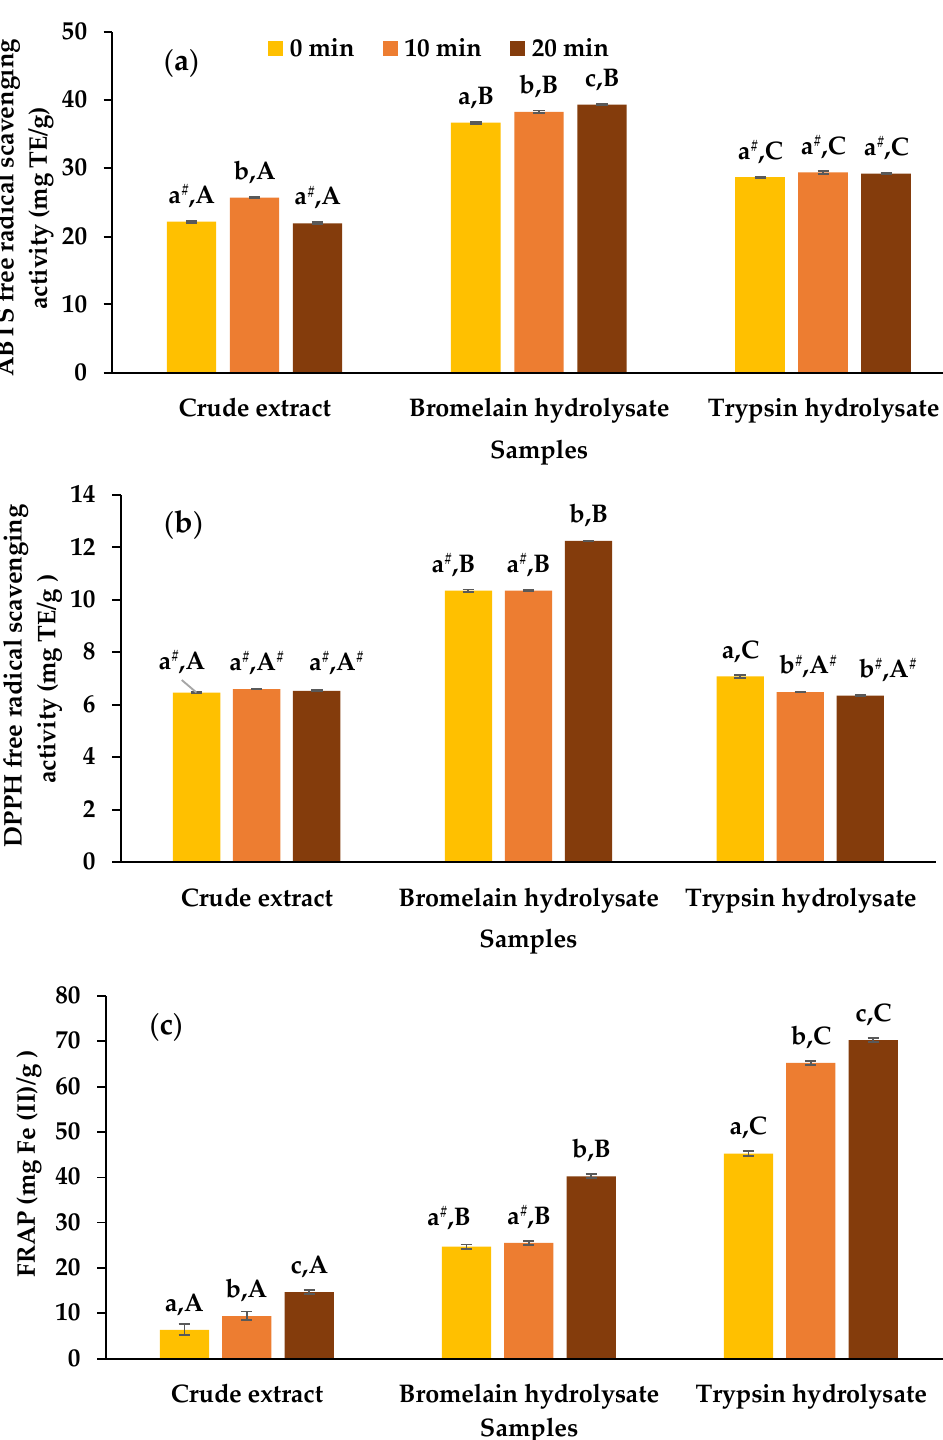
Figure 3. 2,2’-azino-bis(3-ethylbenzothiazoline-6-sulphonic acid) diammonium salt (ABTS) free radical